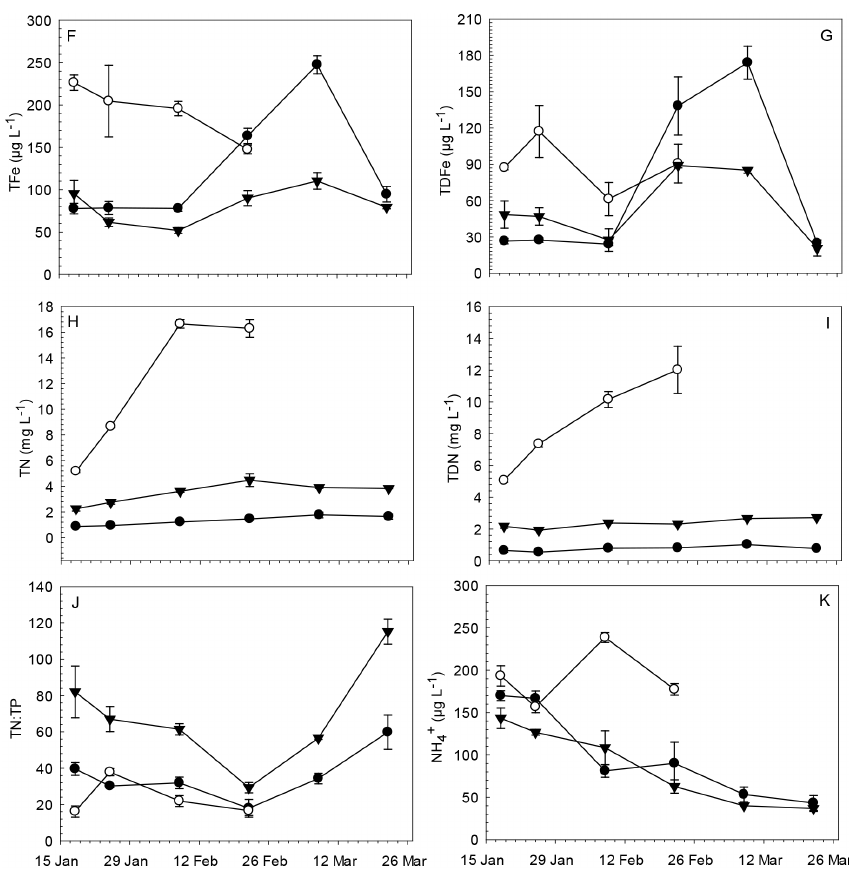
Figure 3. Mean values ( ± one standard error) of physicochemical variables over time (A = pH; B = Air Temp; C = Sal; D = TP; E = TDP; F = TFe; G = TDFe; H = TN; I = TDN; J = TN:TP; K = NH + ) in Jackadder, Bibra and Yangebup lakes from January to March 2010. The 4 mean is calculated from the three locations per